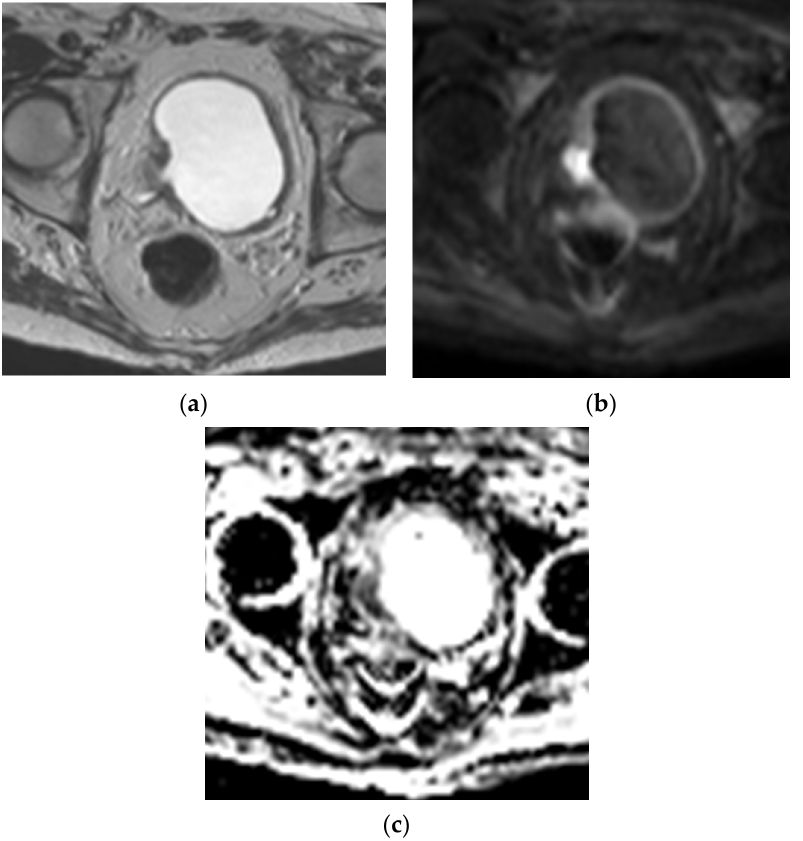
Figure 5. Muscle invasive bladder cancer on MRI ( a ) Axial T2WI shows a muscle invasive mass in the right bladder wall, seen as a T2 intermediate signal lesion (solid white arrow) invasive into the muscularis propria which is T2 hypointense. The mass is located at the ureterovesicular junction, causing hydroureter (dashed white arrow). ( b ) Axial DWI image, showing the hyperintense mass invading the muscularis propria, which is T2 intermediate signal on DWI. ( c ) ADC map showing hypointensity in the area of DWI hyperintensity, confirming restricted diffusion.